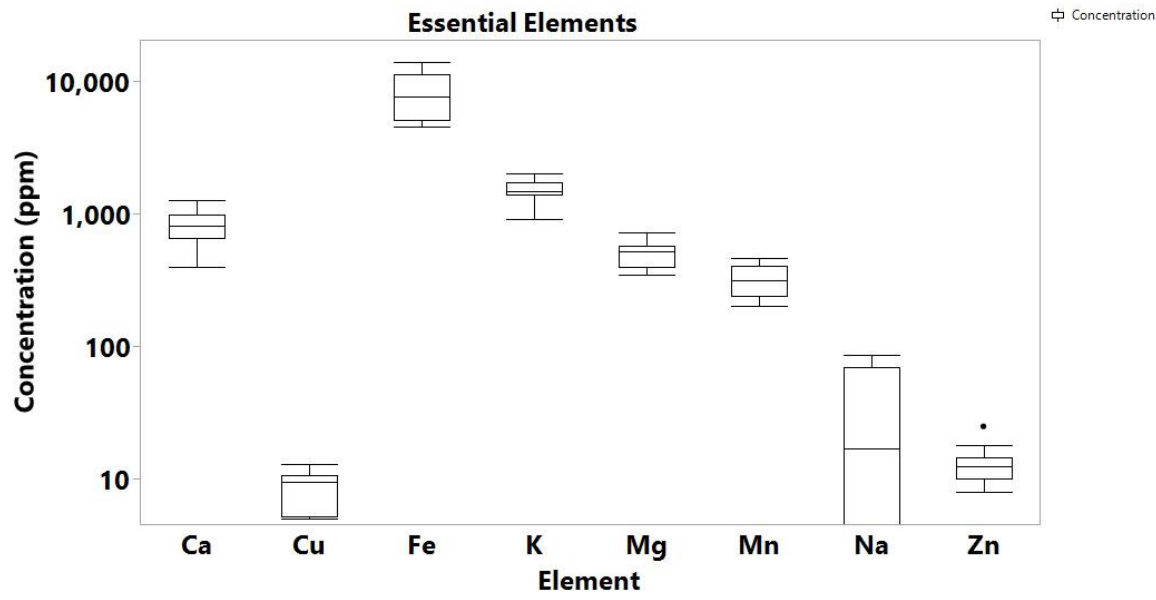
Figure 2. Box plot of essential elements concentration in soil samples.